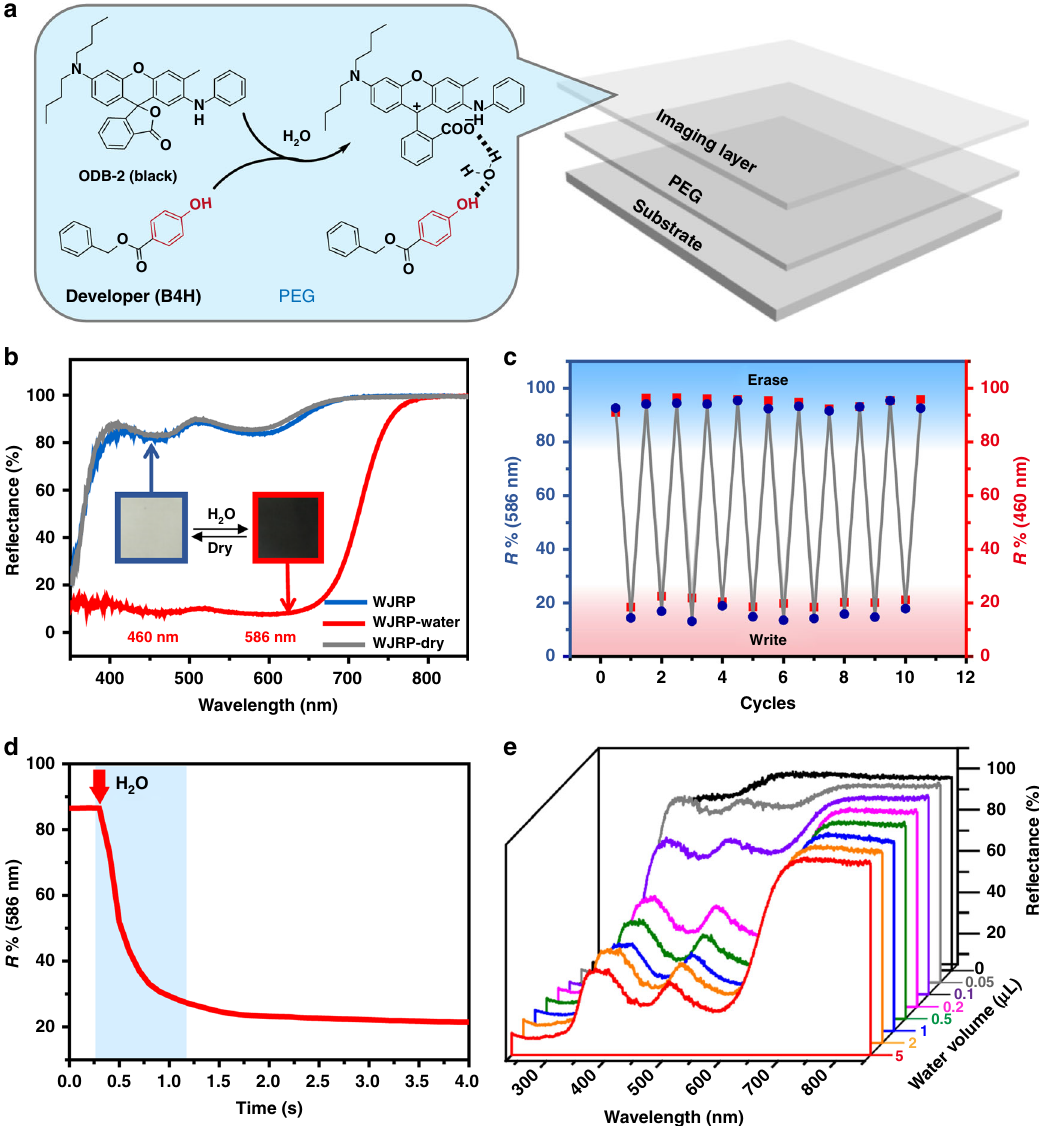
Fig. 2 Structure and basic performances of WJRP. a The preliminary structure of WJRP and the composition of this hydrochromic system in the imaging layer of WJRP (black dashed line: H-bonding). b The re fl ective UV-vis spectra of the WJRP before and after addition of water as well as drying the WJRP. c Plots of the re fl ectivity at 460 nm (red dots) and 586 nm (blue dots), respectively versus the number of cycles as the WJRP is cycled through water spraying (write) and water removal (erase) by means of heating at 80 °C. d Time-dependent re fl ection variations of black WJRP at 586 nm during exposure to a water droplet (red arrow: the point of adding water). e The re fl ective UV – vis spectra of WJRP after exposure to different volume of